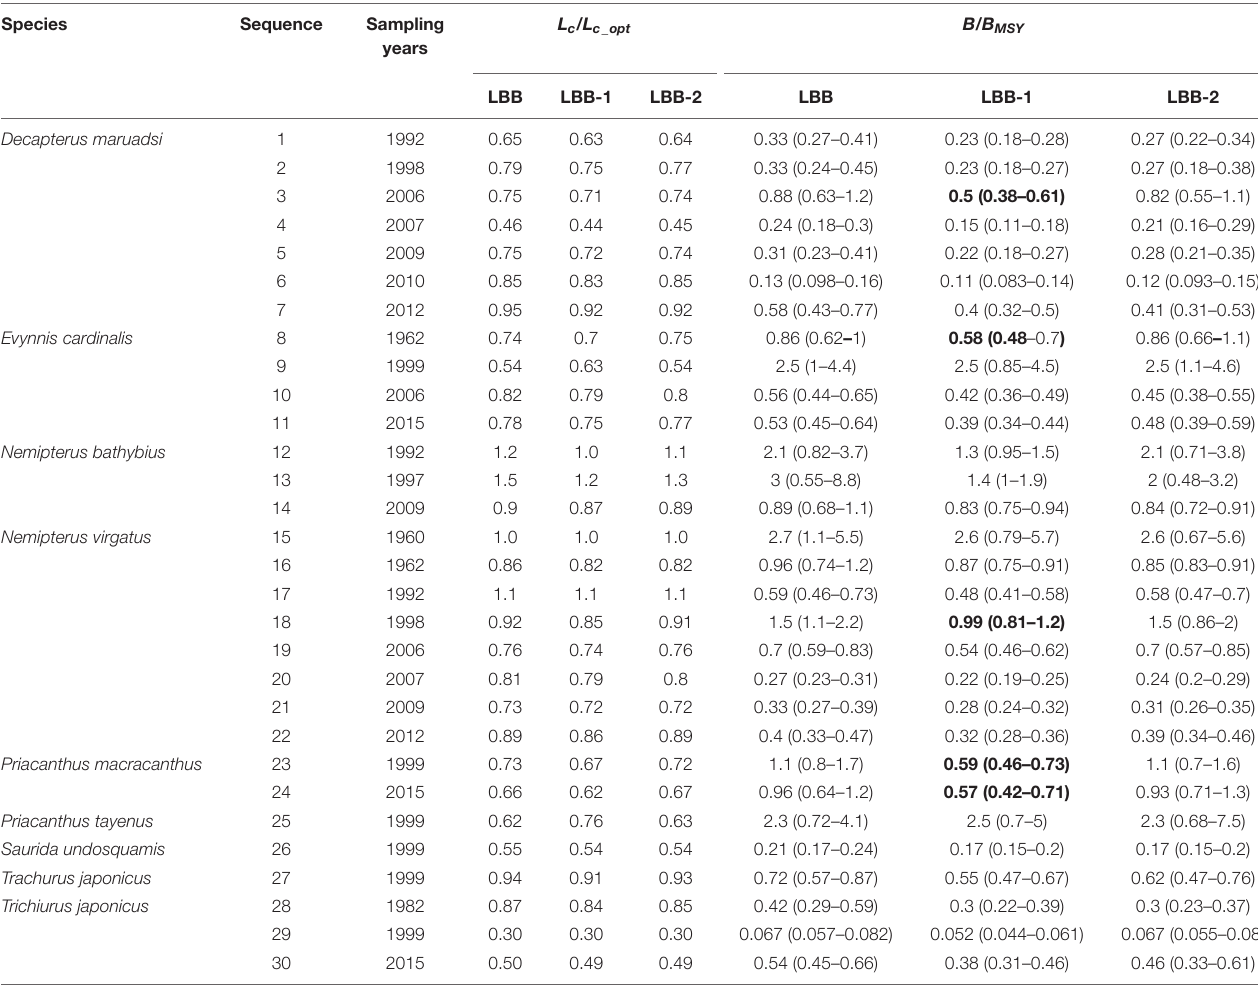
TABLE 4 | Comparison of assessment results of LBB method and two modified methods. Species